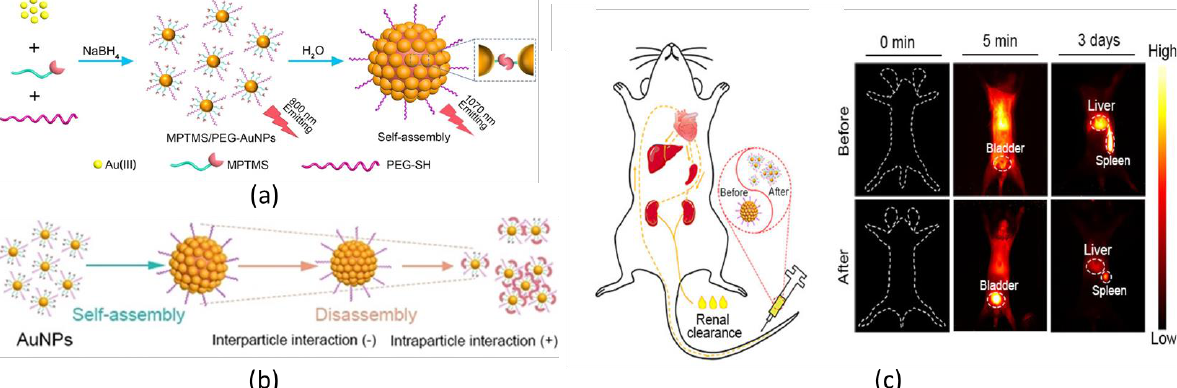
Figure 6. Schematic representation of ( a ) the synthetic route of the MPTMS/PEG-AuNCs and the ( b ) self-assembly/disassembly of MPTMS/PEG-AuNCs. ( c ) In-time renal clearance and liver and spleen retention evaluations by NIR-II bioimaging ( λ exc = 808 nm, λ em > 970 nm) in mice after injection of MPTMS/PEG-AuNCs before and after disassembly. Adapted with permission from Ref. [123] . Cop- yright 2022 Wiley-VCH GmbH.